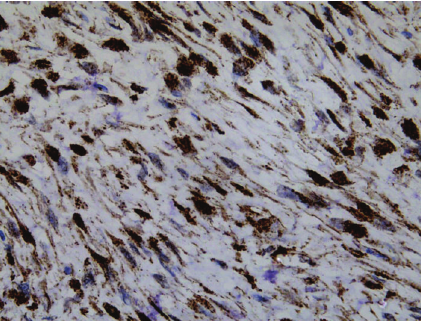
Figure 9: The cells showing immunoreactivity to beta-catenin